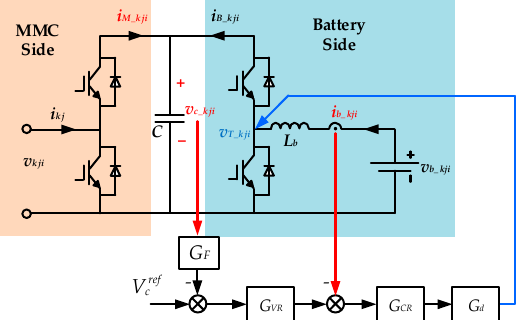
Figure 9. Local circuit of the bidirectional DC/DC converter with control diagram.